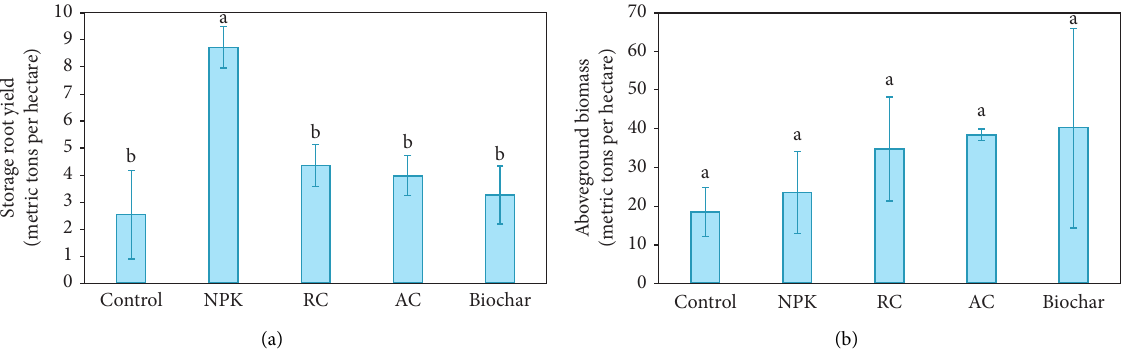
(a) Figure 2: Storage root yield (a) and aboveground biomass (b) of sweet potato variety Beauregard grown for 92 days. Error bars rep- resent ± one standard error ( n � 3). Means followed by the same letter are not significantly different ( p > 0.05). Control: no amendment; NPK: synthetic fertilizer; RC: regular compost; AC: accelerated compost; and biochar: biochar produced from walnut shell feedstock.